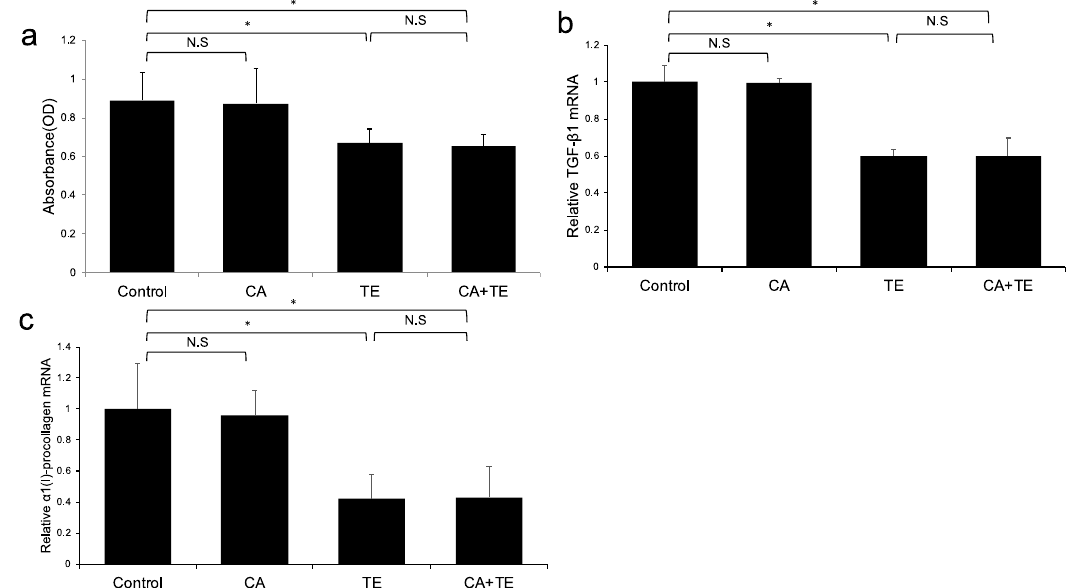
Figure 4. Effects of canagliflozin (CA; 10 µM) and teneligliptin (TE; 5 µM) on cell proliferation ( A ) as well as mRNA expression of TGF- β 1 ( B ) and α 1 (I)-procollagen ( C ) in activated